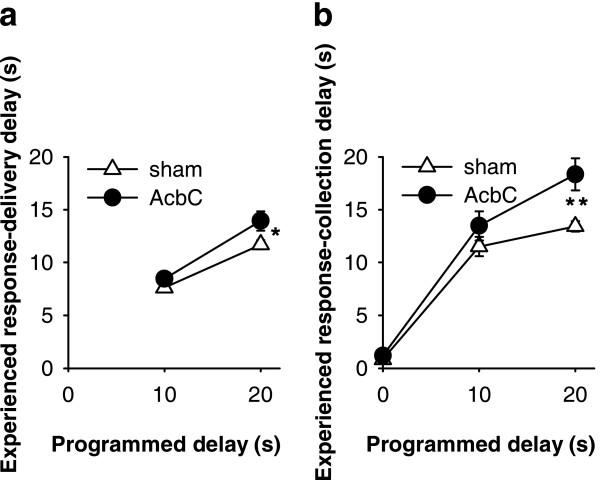
Programmed and experienced delays to reinforcement following AcbC lesions made after initial training AcbC-lesioned rats experienced slightly longer response-delivery and response-collection delays than shams in the 20 s condition. Lesions were made after initial training; postoperative experienced delays are plotted. (Compare Figure 6, in which rats had no preoperative experience of the task.) (a) Mean experienced response-delivery delays (one value calculated per subject). When the programmed delay was 0 s, reinforcers were delivered immediately so no data are shown. There were main effects of lesion (F1,21 = 9.14) and delay (F1,21 = 87.5, p < .001) but no lesion × delay interaction (F1,21 = 1.91, NS). When the programmed delay was 10 s, the experienced delays did not quite differ significantly between groups (F1,10 = 4.61, p = .057), but when the programmed delay was 20 s, AcbC-lesioned rats experienced longer response-delivery delays (F1,11 = 6.29, * p = .029). (b) Mean experienced response-collection delays (one value calculated per subject). There was a lesion × delay interaction (F2,31 = 3.85, p = .032), as well as main effects of lesion (F1,31 = 11.9, p = .002) and delay (F2,31 = 171, p < .001). AcbC-lesioned rats did not experience significantly different delays when the programmed delay was 0 s (F1,10 = 1.74, NS) or 10 s (F1,10 = 1.49, NS), but experienced significantly longer response-collection delays when the programmed delay was 20 s (F1,11 = 13.7, ** p = .003).